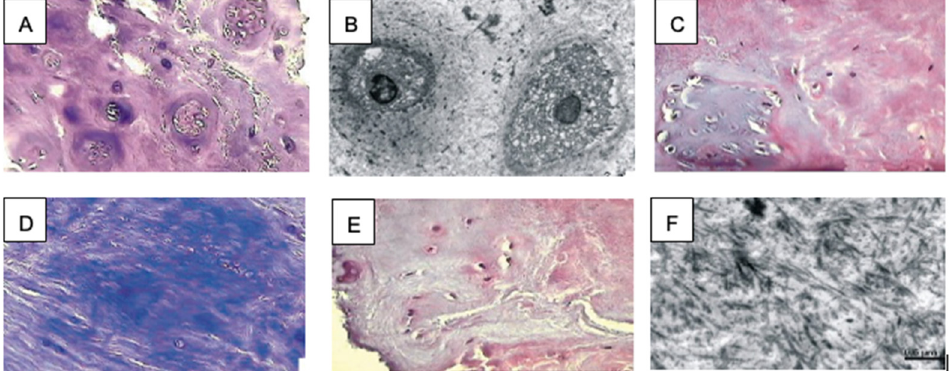
Figure 9. Morphological structure of the IVD of a patient in 2.5 years after LRD: ( A ) numerous iso- genic groups of chondrocytes with high levels of PGs. Toluidine Blue, X400; ( B ) biosynthetically active chondrocytes in isogenic groups, thin CFs and PGs around the cells in the ECM. SEM, X6000; ( C ) on the left is the transition area of fibrous cartilage into hyaline ones. H&E, X400; ( D ) in the center-bright metachromatic areas. Groups of chondrocytes of the type of hyaline cartilage cells are visible. Toluidine Blue, X400; ( E ) on the left is a fibro-hyaline cartilage: chondrocytes in lacunae and homogeneous, in places fine-fibrous, basophilic ECM. H&E, X400; ( F ) CFs and PGs are randomly located in the ECM of hyaline-like cartilage. SEM X40000.